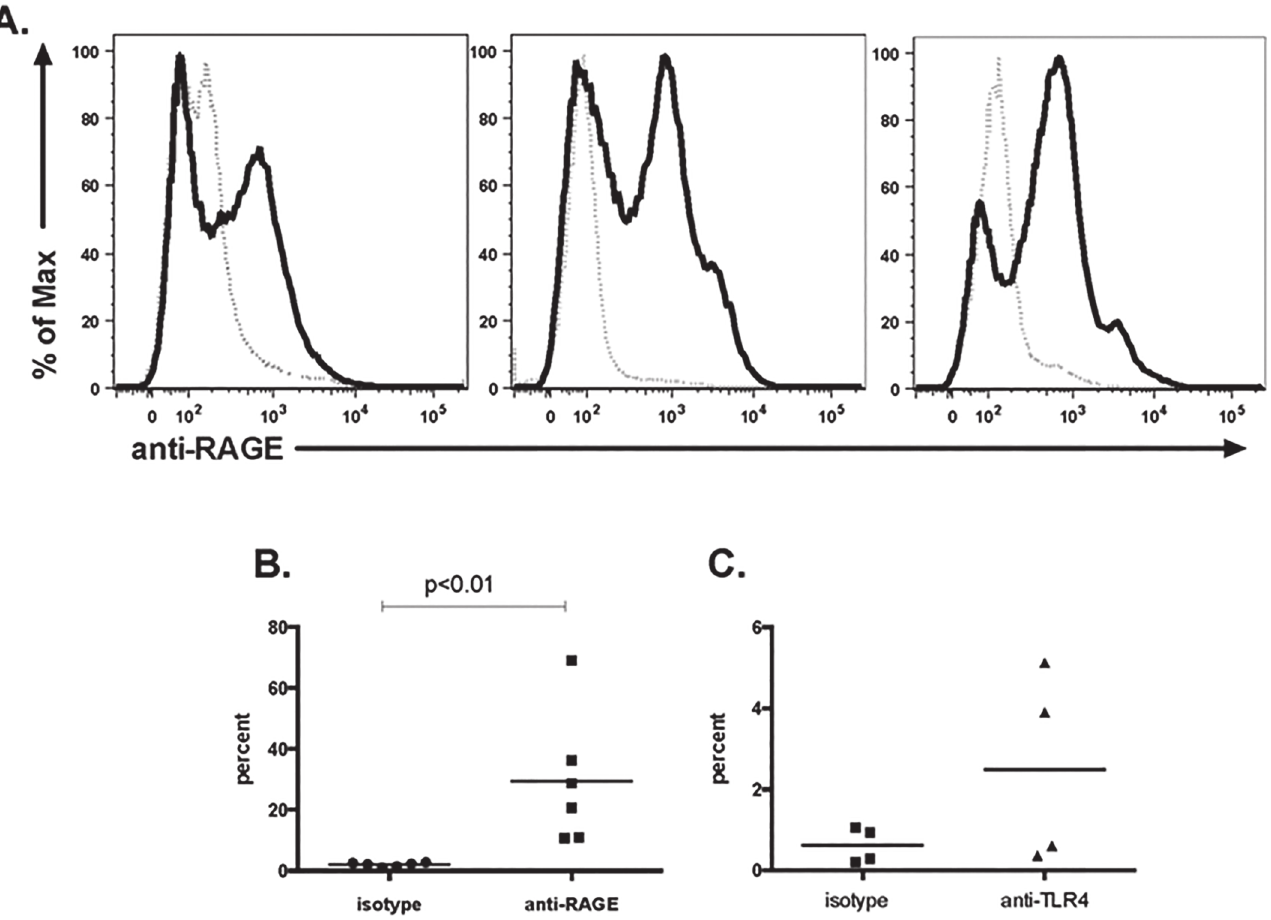
Fig 1. Expression of HMGB1 receptors on eosinophils. Human eosinophils were isolated from peripheral blood of normal donors. Surface expression of RAGE and TLR4 was evaluated by flow cytometry. (A) RAGE expression (heavy solid line) in comparison to isotype control (dotted line) in three individual donors. (B) RAGE expression in from 6 normal donors shown in comparison to isotype control. (C) TLR4 expression in from 4 normal donors shown in comparison to isotype control.